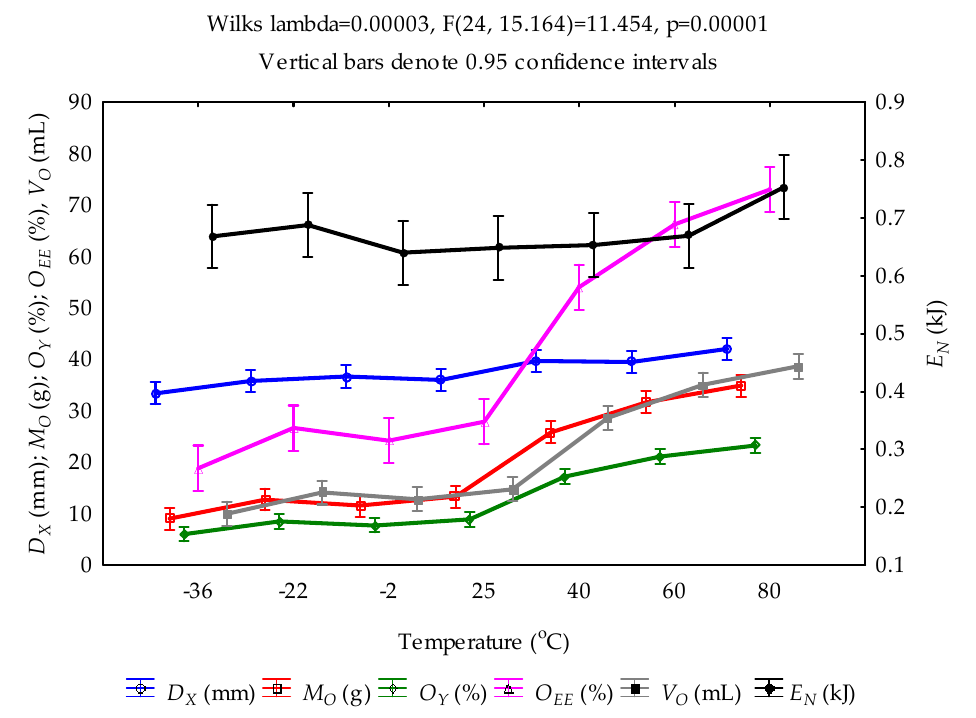
Figure 2. Least square means of calculated parameters ( D X : deformation; M O : mass of oil; O Y : oil yield; O EE : oil expression efficiency; E N : energy and V O : volume of oil) grouped by temperature (°C).